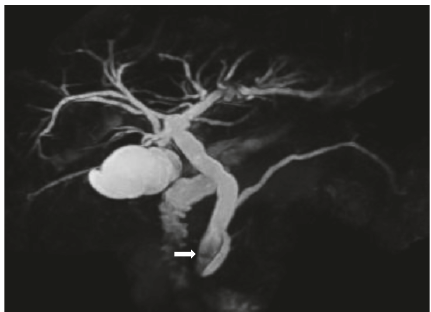
Figure 2: Magnetic resonance cholangiopancreatography image. Radiology examinations revealed gall stones and common bile duct stones (arrow), but no fistulas.